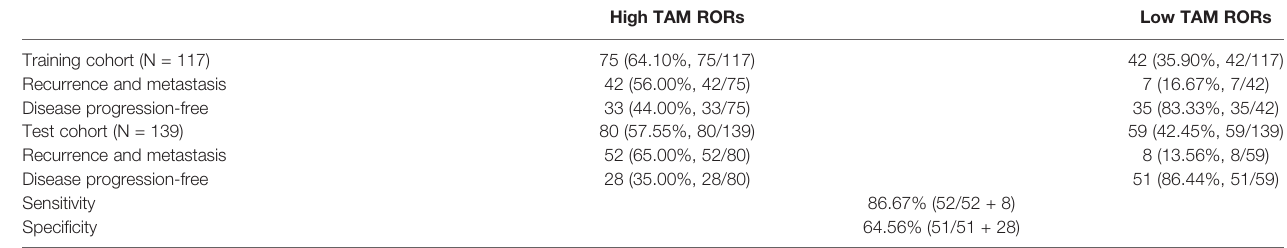
TABLE 4 | TAM RORs predicts recurrence and metastasis in breast cancer.